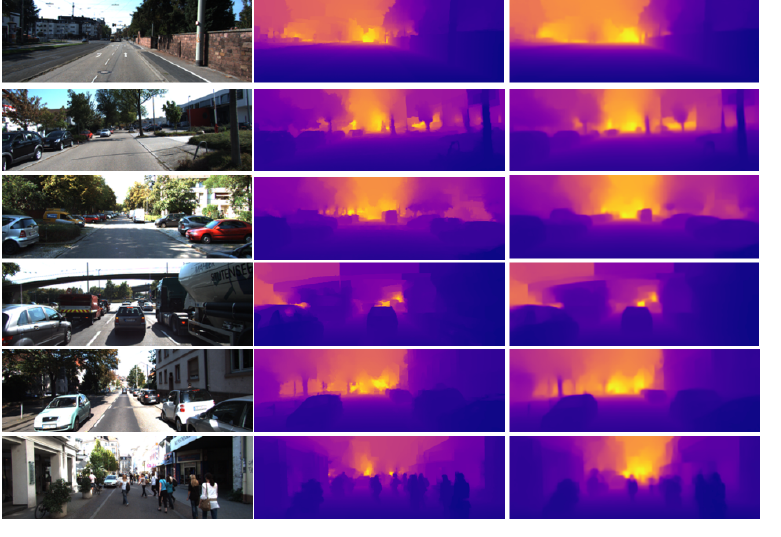
Figure A2. Example outcomes for the proposed method on KITTI. Columns from left to right: original RGB images, ground truth depth maps, and proposed model predicted depth maps. Colors indicate depth; yellow is far, and purple is close. Ground truth maps were interpolated from sparse measurements for better visualization.